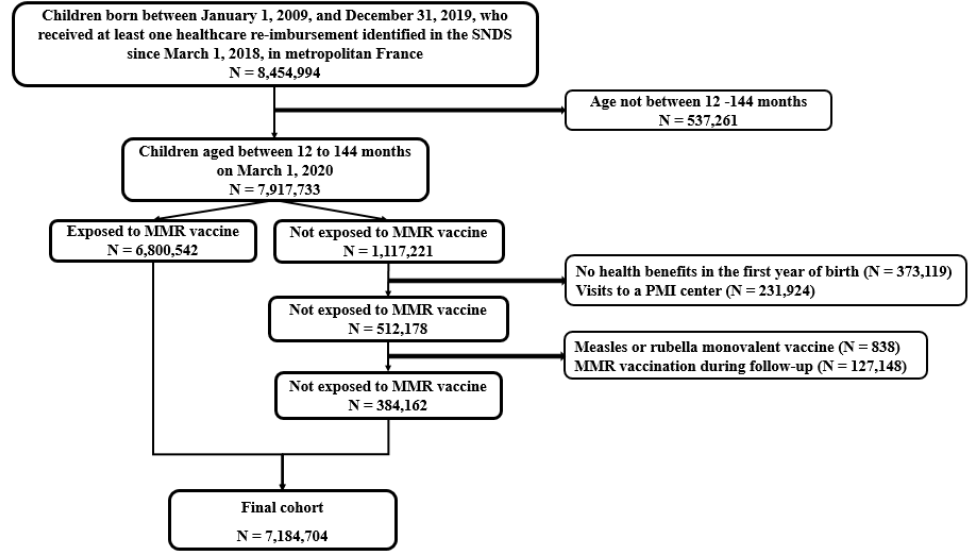
Figure 1. Study flowchart.